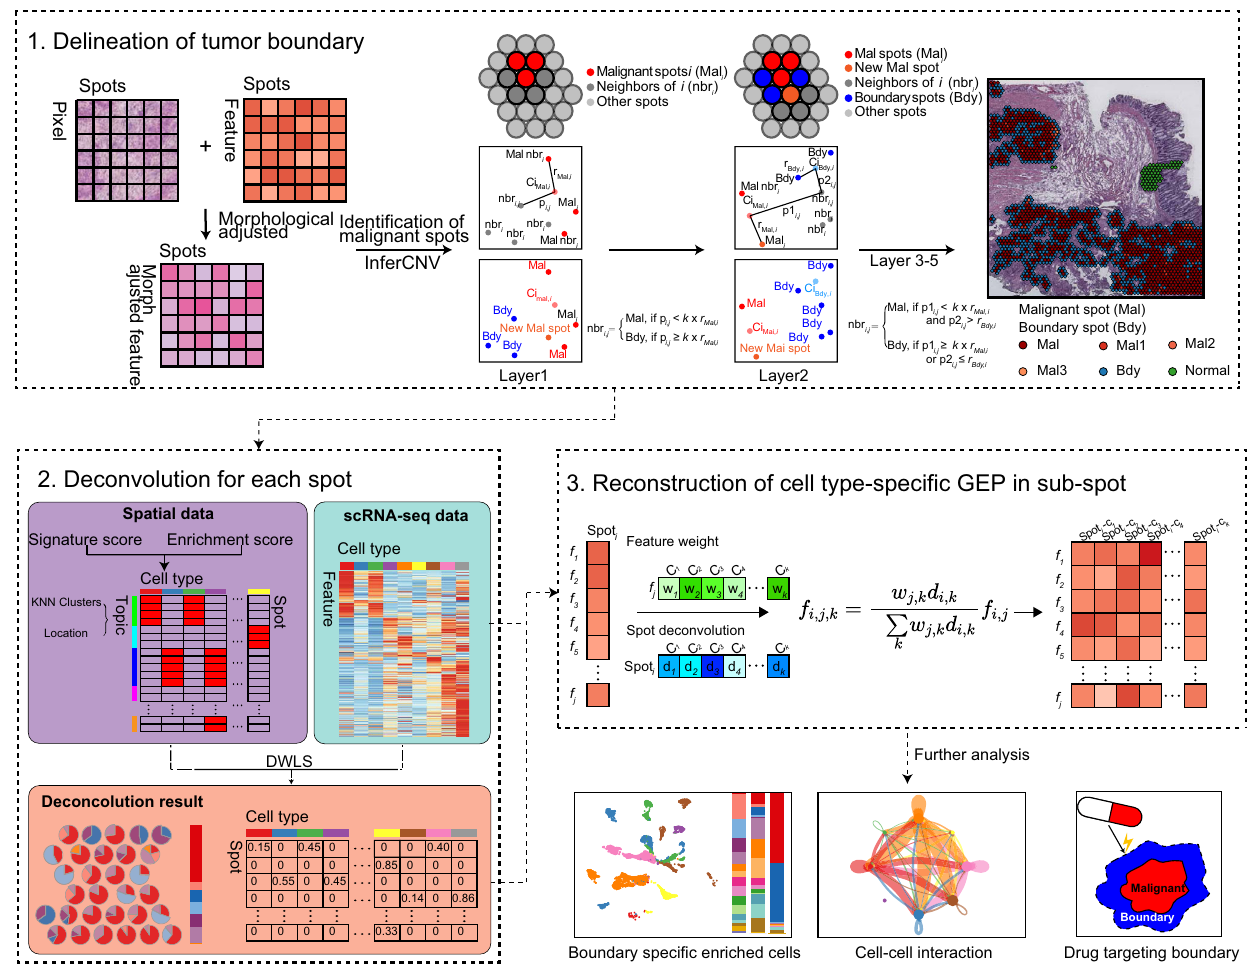
Fig. 1 | Schematic representation of the Cottrazm work fl ow. Step-by-step illus- tration of the Cottrazm pipeline is as follows: 1. Delineation of tumor boundary. Initially, based on neighboring spot information and morphological distances of HE-staining images, Cottrazm normalizes ST gene expression data to obtain a morphologicallyadjustedexpressionmatrix.Thenclusteredbyk-nearestneighbor (KNN) algorithm, clusters are identi fi ed using copy number variation by InferCNV which de fi ne the core spots of malignant cells. Further, Cottrazm arranged spatial spots on hexagonal systems, extrapolated layer by layer from core spots of malignant cells and determined the identity of spots according to UMAP distance to tumor centroid as malignant cell (Mal) spots or tumor boundary (Bdy) spots. WhenallneighborsofMalspotsarenotclassedastumortissue,theextrapolationis completed. Remaining spots are therefore labeled as nMal. 2. Deconvolution for each spot, Cottrazm generated a signature score matrix from each cell type in the